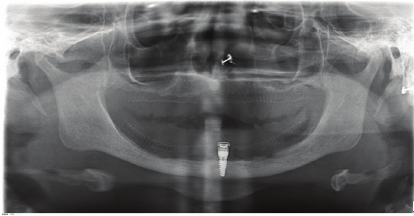
Figure 4: Postprosthesis